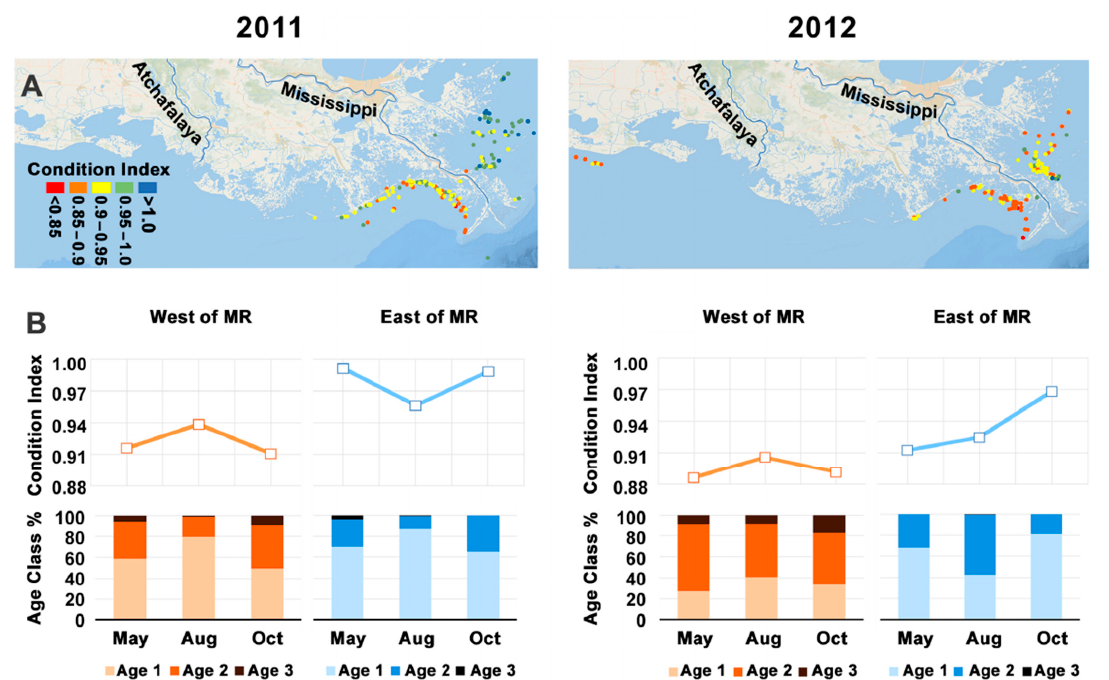
Figure 3. ( A ) Map of Gulf menhaden condition index K n in 2011 and 2012, and ( B ) age-specific mean condition index of samples collected by Daybrook Fisheries, Inc. during May, August and October. Condition index symbols in panel B obscure 95% confidence intervals (598 ≤ n ≤ 1077). MR = Mississippi River.